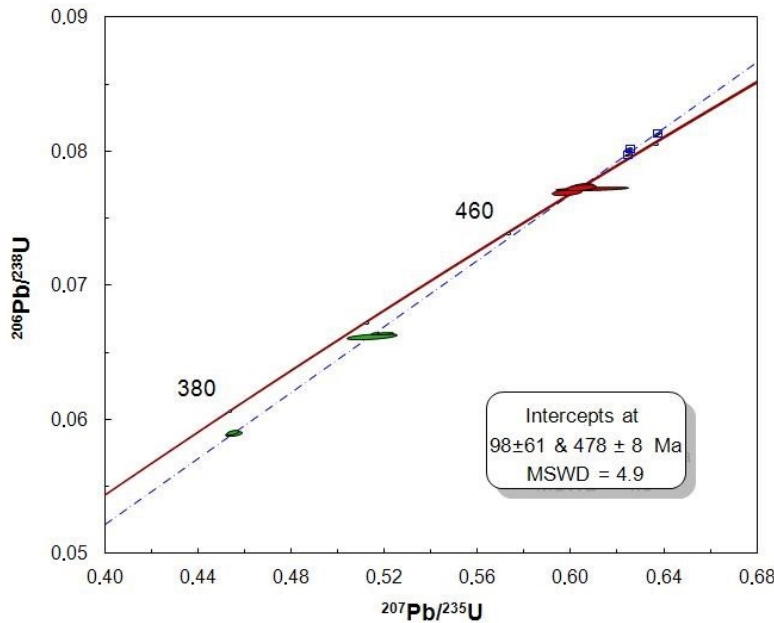
Figure 11. Concordia diagram of the cassiterites from the Yaroslavskoe deposit (sample DV-1—red ellipses; sample 4088-112—blue ellipses in squares) and from the Chapaevskoe deposit (sample 4088-107—green ellipses).